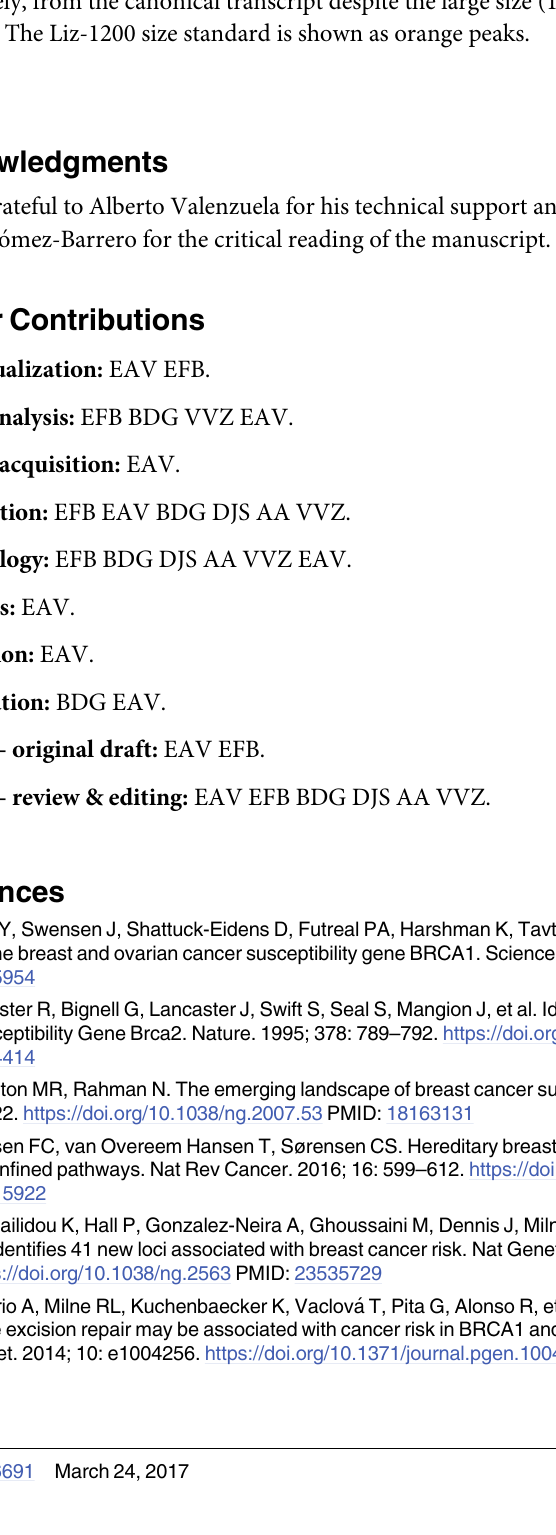
RT-PCR products were run on an agarose gel (1.0%) and stained with Ethidium Bromide. Sev- eral aberrant transcripts are visualized, some of which are indicated by arrows. S3 Fig. High resolution of capillary electrophoresis of fluorescent RT-PCRs. Electrophero- grams of the wild type minigene and mutations c.7806-1G > A and c.7806-1_7806-2dup were overlaid. Transcripts ex17-del1 and ex17-insAG differed in size by only 1 and 2 nucleotides, respectively, from the canonical transcript despite the large size (1,012 nt) of the RT-PCR products. The Liz-1200 size standard is shown as orange